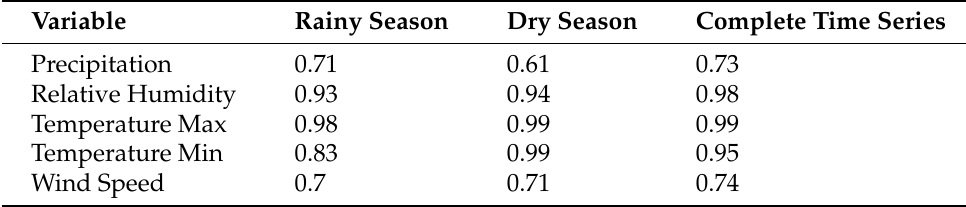
Table 3. Correlation coefficients for Station Dédougou (TA00163) for dry and wet seasons (wet